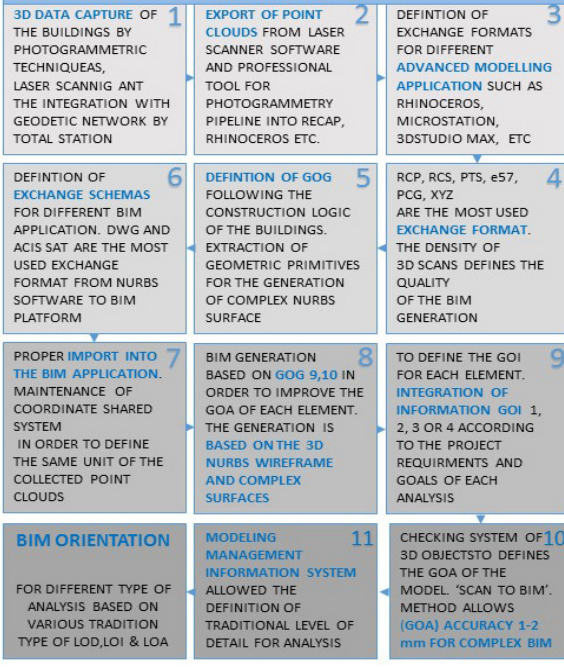
Fig. 3. The benefits of MMSI are not limited to